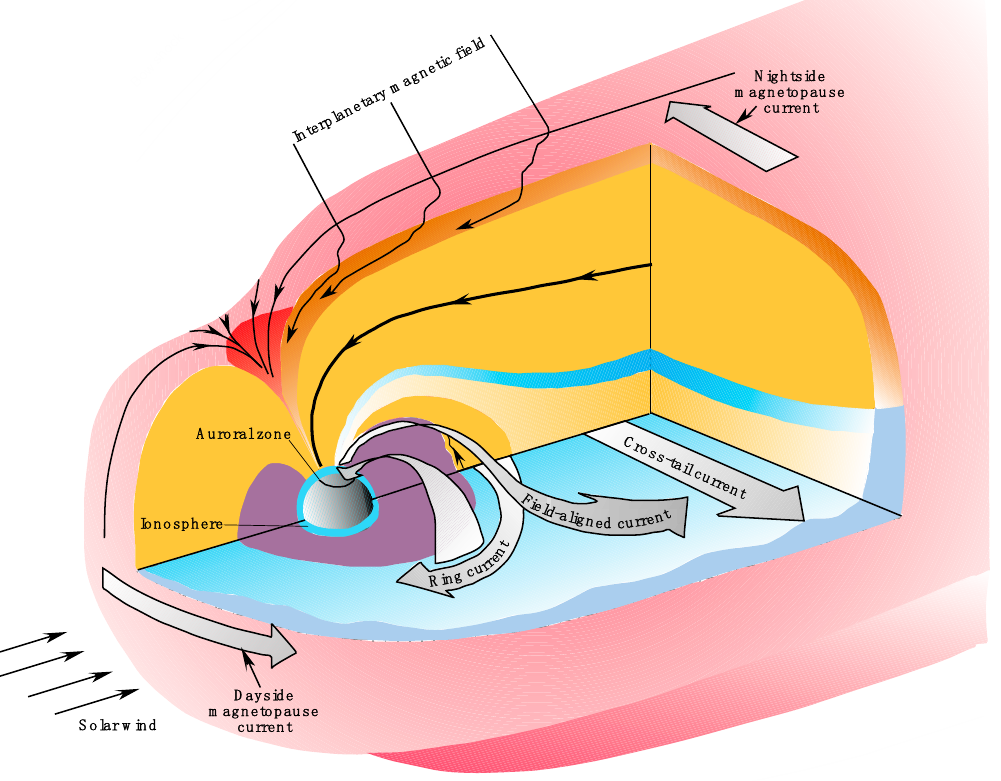
Figure 1. A schematic diagram to illustrate the primary current systems in the Earth’s magnetotail plasma sheet.